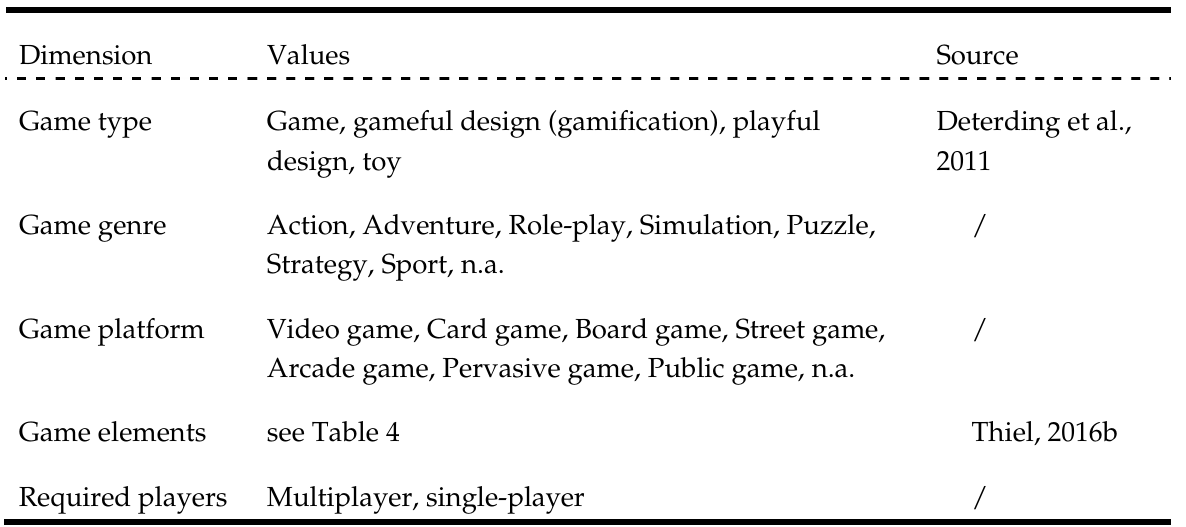
Table 2: The Game-Related Dimensions (Second Axis) Dimension Values Source Game type Game, gameful design (gamification), playful design, toy Game genre Action, Adventure, Role-play, Simulation, Puzzle, Strategy, Sport, n.a. Game platform Video game, Card game, Board game, Street game, Arcade game, Pervasive game, Public game, n.a. Game